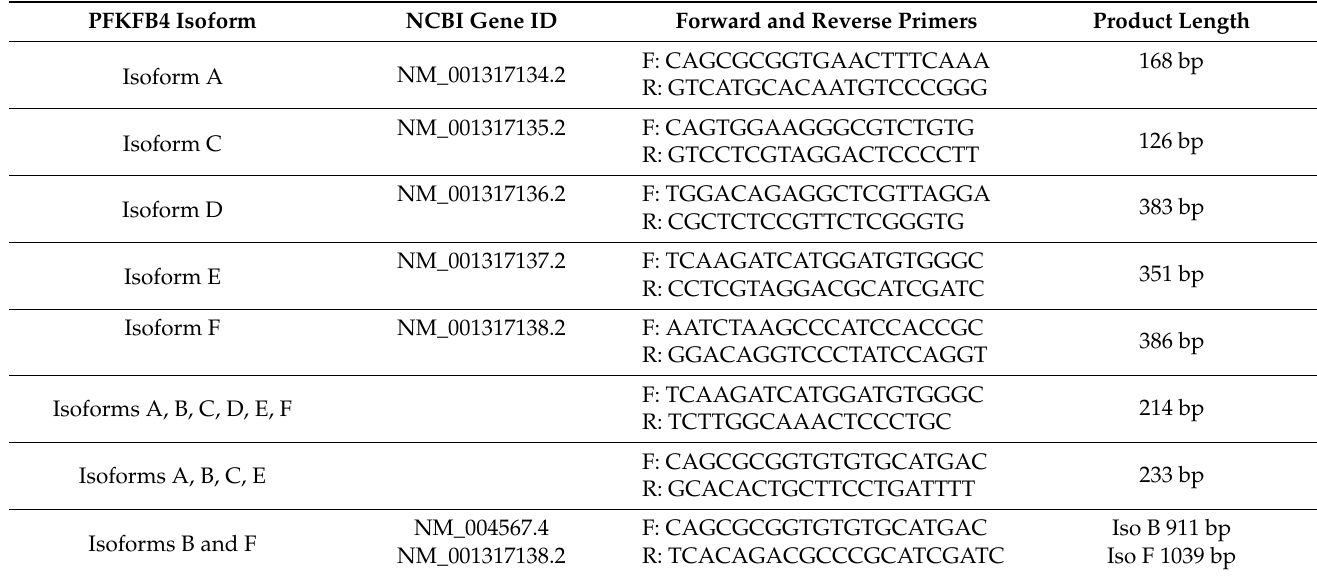
Table 1. PCR primer